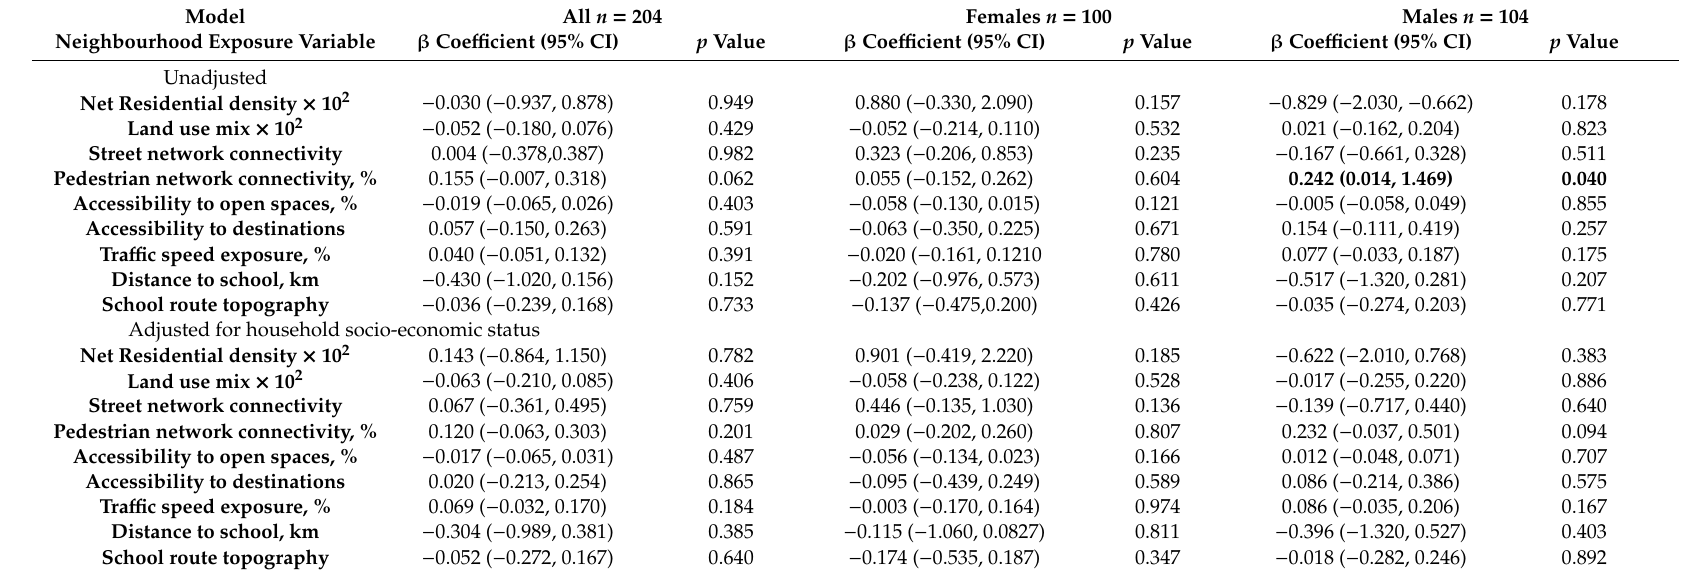
Table 3. Linear regression analyses examining associations between neighbourhood built environment factors and fat free